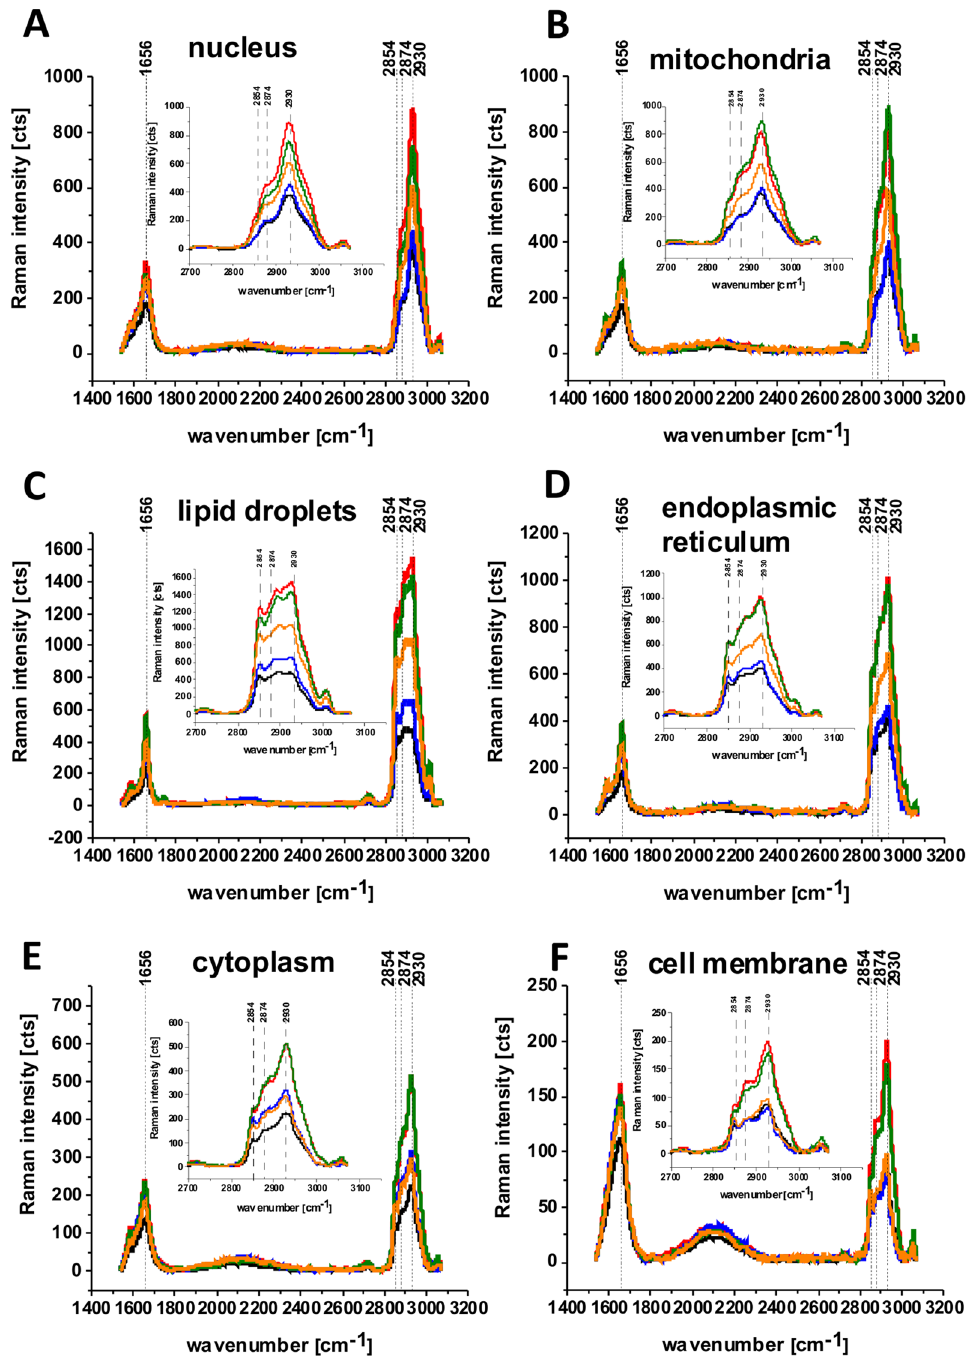
Figure 5. The average Raman spectra of human lung single cell CCL-185 without glucose supplementation (black line), supplemented with glucose (green line) and deuterated glucose (red line) at normal conditions (5 mM) and supplemented with glucose (orange line) and deuterated glucose (blue line) at hyperglycemia conditions (100 mM) for 1400–3200 cm −1 spectral region and for 2700–3150 cm −1 spectral region obtained from Raman images of separate clusters identified by Cluster Analysis method assigned to: nucleus ( A ), mitochondria ( B ), lipid droplets ( C ), endoplasmic reticulum ( D ), cytoplasm ( E ) and cell membrane ( F ); integration time 0.3 s in the high frequency region, laser power 10mW